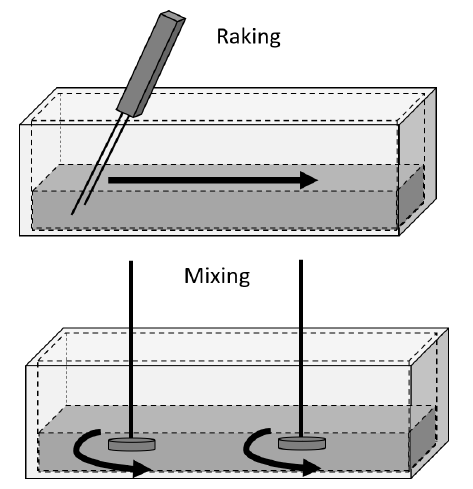
Figure 5. Illustration of the raking and shear mixing steps to introduce order in the casting